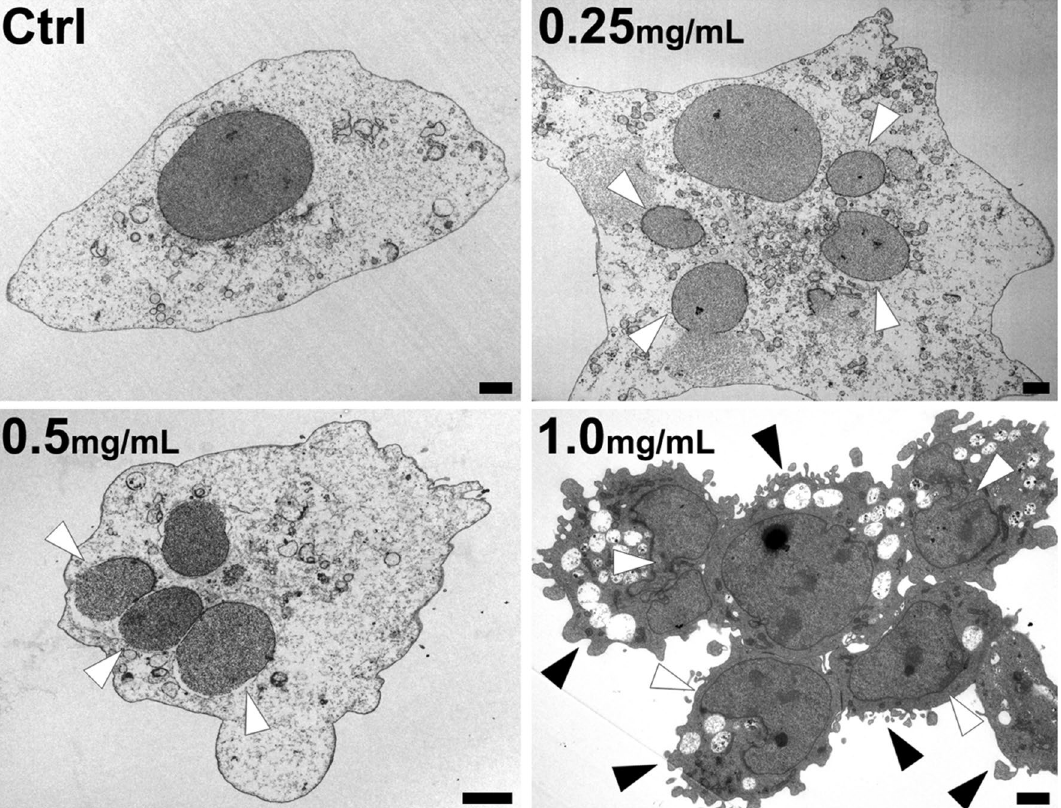
Figure 4. Cellular ultrastructural change of HCECs induced by MXF exposure. MXF exposure (48 h) induced significant apoptotic change of HCECs. Nuclear fragmentation (white arrowheads) was observed at 0.25 and 0.5 mg/ml of MXF exposure. At 1.0 mg/ml of MXF exposure, cytoplasmic fragmentation was also observed, indicating more severe damage to HCECs (black arrowheads). Data shown are the representatives of three independent experiments Ctrl: no treated normal control. Scale bar = 2